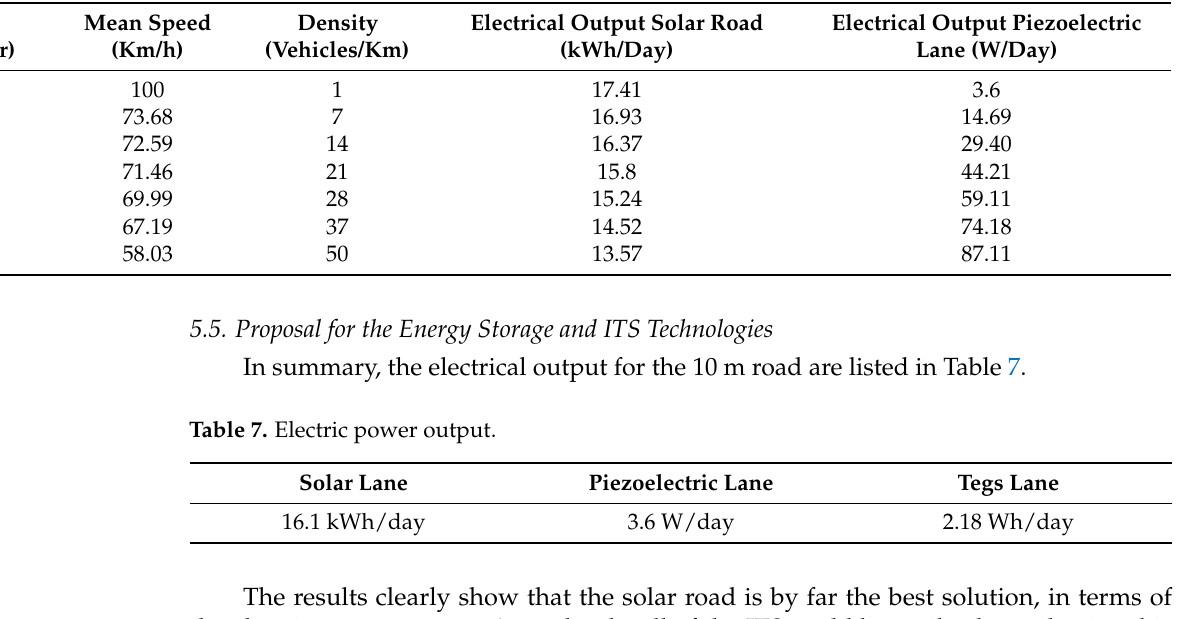
Table 6. Electrical output of the solar and piezoelectric lanes at different traffic flows.